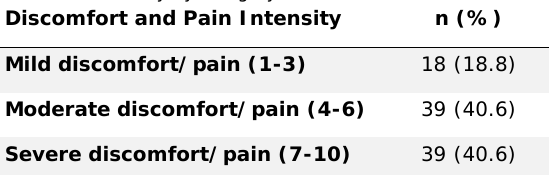
Table 3. Intensity by